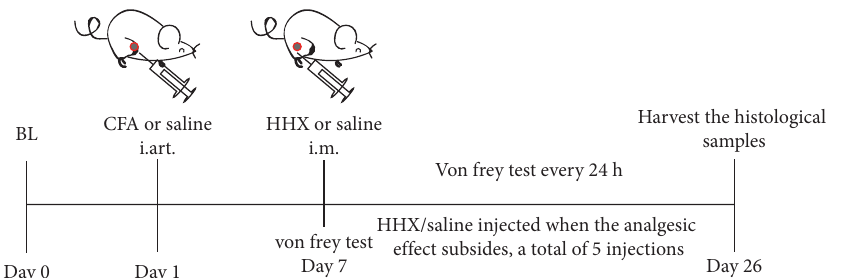
Figure 1: Flow chart of the study evaluating the antinociceptive effects of HHX in a mouse model of monoarthritis